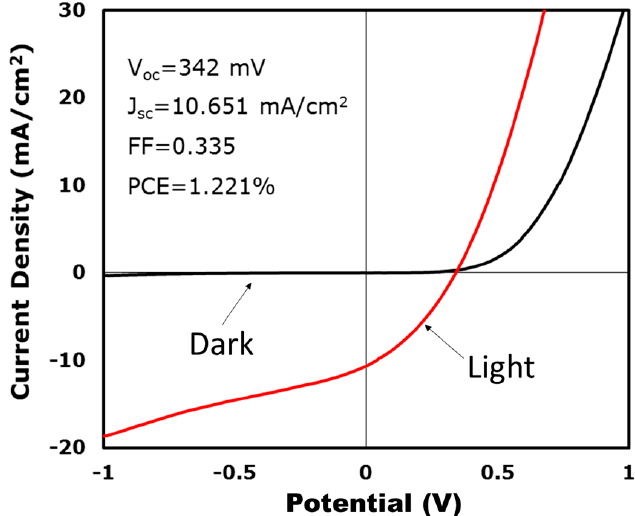
Figure 6. Current–voltage properties of a CuInTe 2 nanocrystals photovoltaic (PV) device.